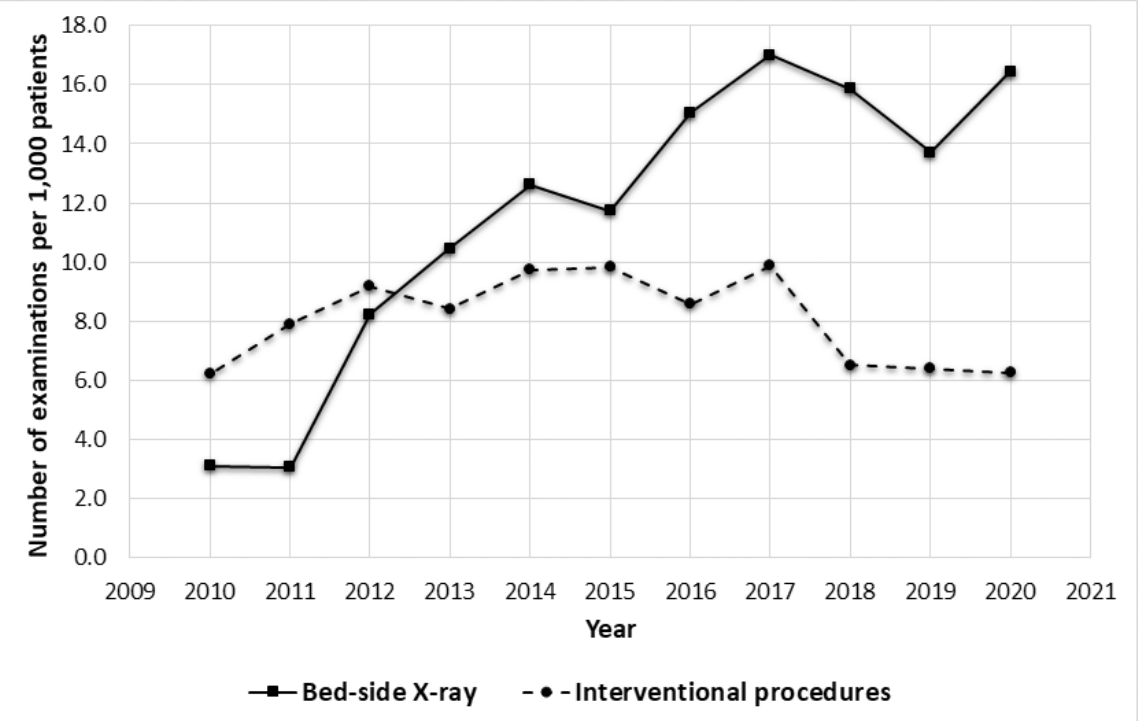
Figure 2. Annual changes in the number of bedside X-ray examinations and interventional proce- dures.